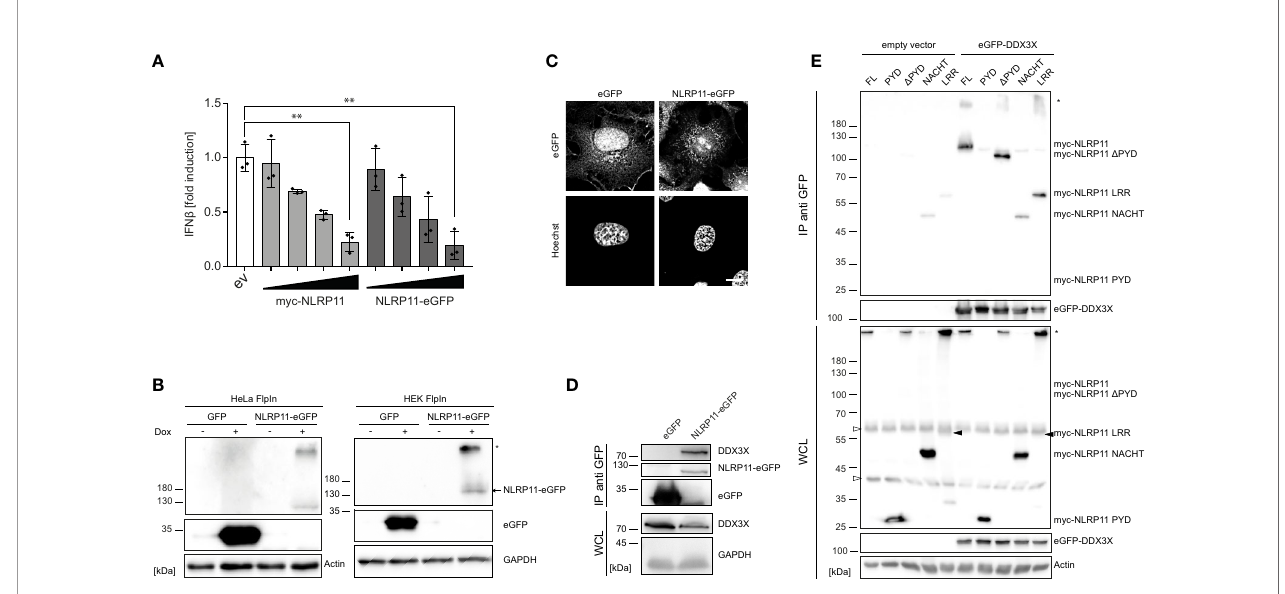
FIGURE 1 | NLRP11 interacts with DDX3X. (A) ifnb luciferase reporter assay in HEK293T cells overexpressing FLAG-IKK ϵ (5 ng) and either empty vector (ev), myc- NLRP11, or NLRP11-eGFP. Means of three independent experiments conducted in triplicates, relative to the mean of 0 ng NLRP11, ± SEM are shown. **p < 0.01; Welch ’ s two-sided t-test. (B) Immunoblot of protein lysates of HEK293- and HeLa-eGFP and -NLRP11-eGFP cells, induced overnight with doxycycline. Probing for GFP and actin, or GAPDH as loading control is shown. Monomeric NLRP11-eGFP is marked by an arrow and aggregated NLRP11 by an asterisk. (C) Immuno fl uorescence micrographs of HeLa-NLRP11-eGFP cells. Cells were induced with doxycycline overnight, fi xed and nuclei were stained. 3D-deconvolution of z-stacks of the signal of DNA (lower images) and eGFP (upper images) are shown. Stack size = 0.2 µm. Scale bar = 10 µm. (D) Immunoblots from anti-GFP immunoprecipitations (IP) from HEK293T-eGFP and HEK293-NLRP11-eGFP cells induced over night with doxycycline. IPs were probed for DDX3X and GFP, whole cell lysates (WCL) were probed for DDX3X and GAPDH as loading control. Representative blots for two independent experiments are shown. (E) Immunoblots from anti-GFP IPs from HEK293T cells expressing empty vector, or eGFP-DDX3X and the indicated myc-NLRP11 construct. IP lysates were probed for myc and GFP, whole cell lysates were probed for myc, GFP and actin as a loading control. Representative blots of two independent experiments are shown. *, NLRP11 aggregate; Δ , unspeci fi c